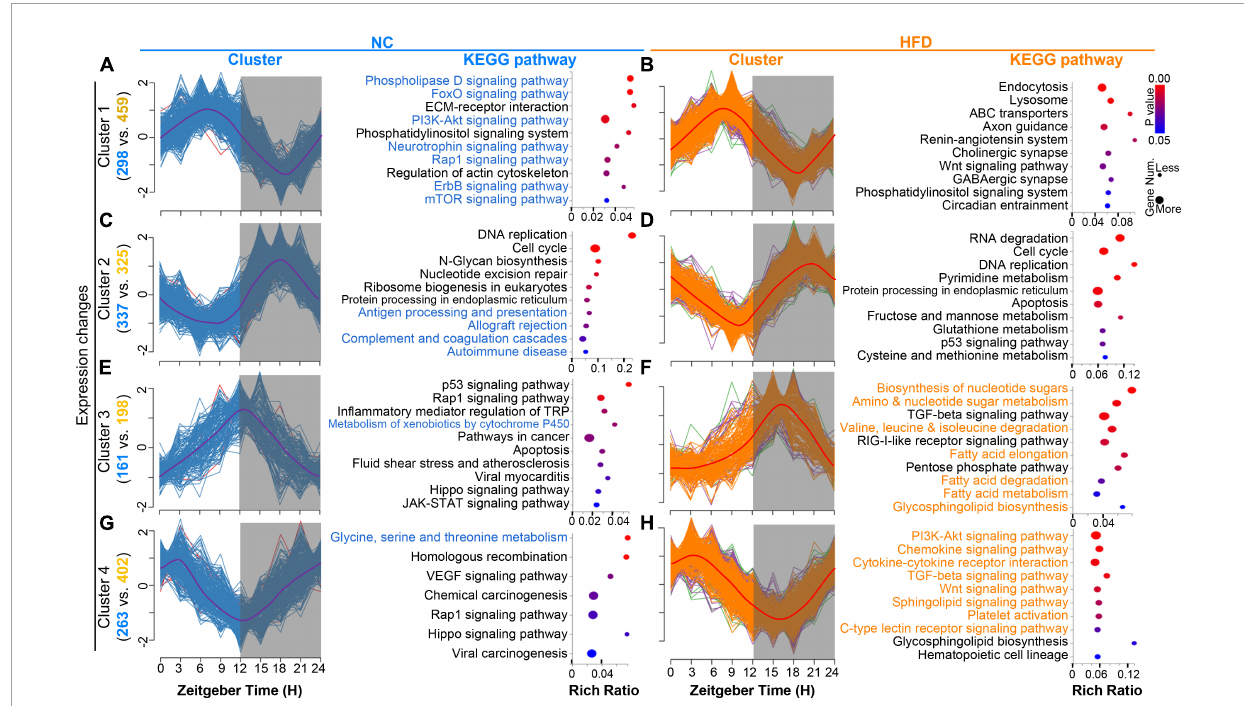
FIGURE4 High-fat diet (HFD) alters the cluster-dependent transcriptomic map. (A,C,E,G) Oscillating patterns of normalized expression for rhythmic genes from four enriched clusters for the MGs of NC-fed mice (left). The enriched KEGG pathways for genes in each cluster ( P < 0.05) are shown in the (right) panel. Gray shading: dark phase. (B,D,F,H) Oscillating patterns of normalized expression for rhythmic genes from four enriched clusters for the MGs of HFD-fed mice (left). The enriched KEGG pathways for genes in each cluster ( P < 0.05) are shown in the (right) panel. Gray shading: dark phase.